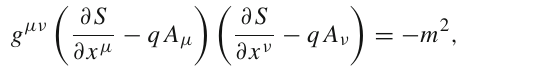
3 Dynamics of charged